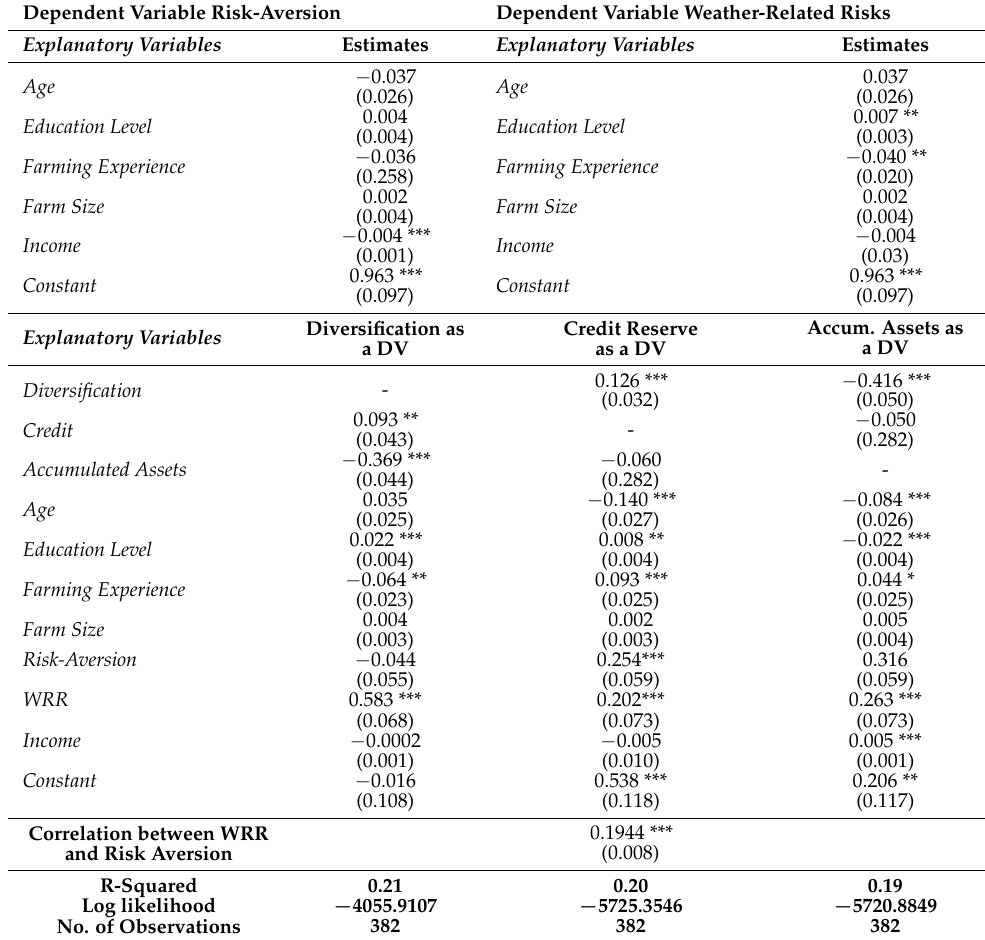
Table 12. Parameter estimates from path analysis show the direct and indirect effect of socioeconomic factors on the adoption of